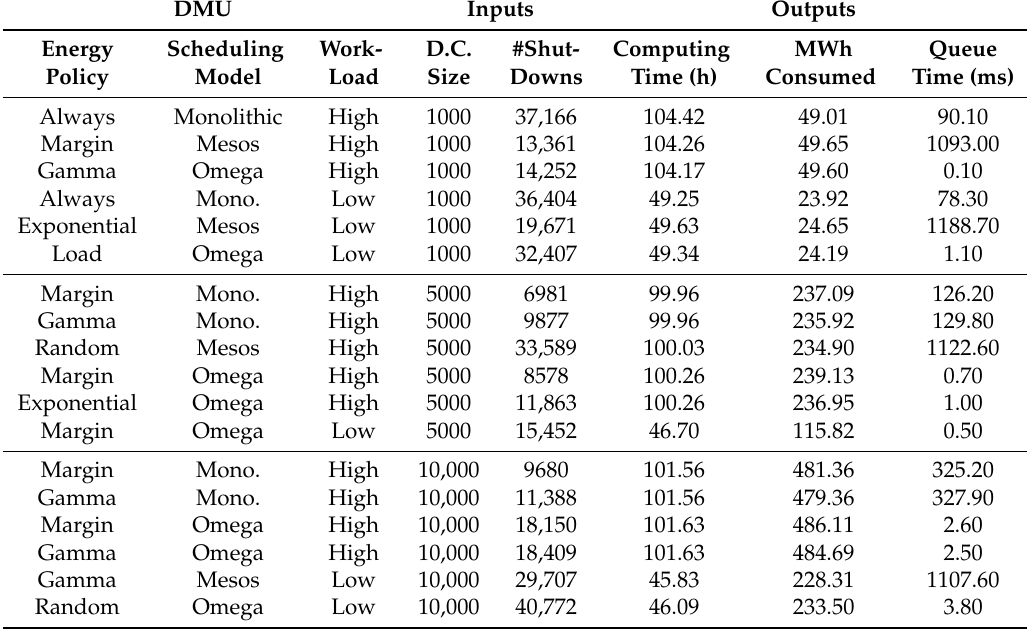
Table 2. Sample from the dataset for DEA analysis. The full dataset showing the results for the 108 DMUs analyzed can be found as the Supplementary Material. Energy policies, scheduling models, data-center sizes and workload types can be found in Sections 3, 4 and 5.2, respectively. D.C.,